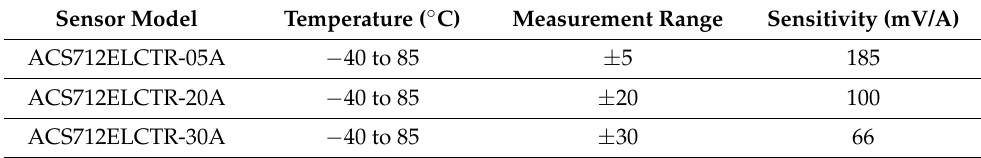
Table 4. Constructive variants of the ACS712 sensor [46,47].